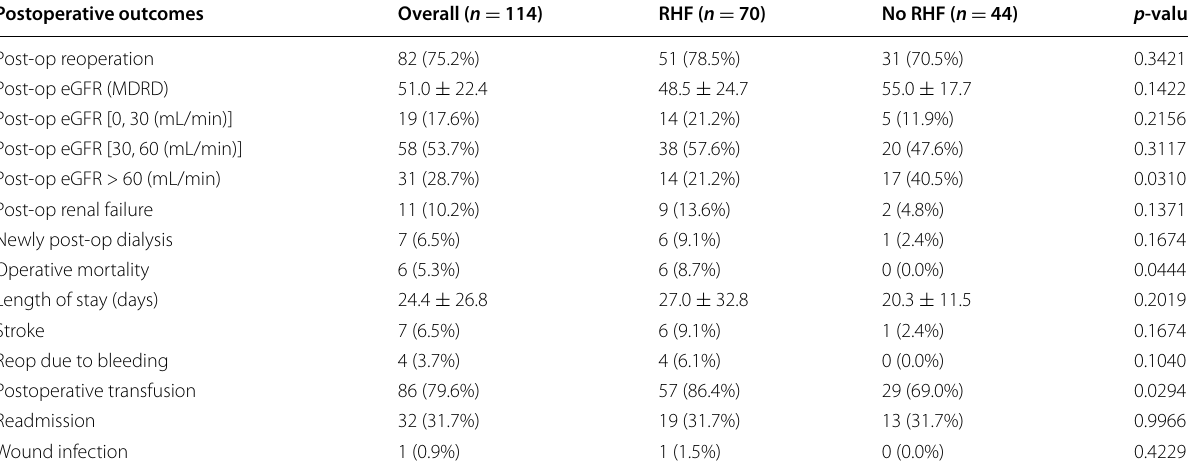
* p ‑values comparing patients with RHF vs. no RHF. **For continuous variables mean glomerular filtration rate, RHF right heart failure